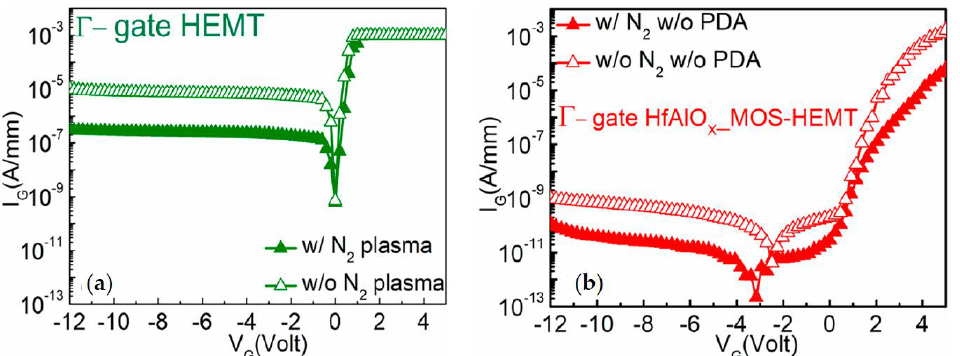
Figure 3. Comparison of gate leakage characteristics of ( a ) Γ -gate HEMT and ( b ) Γ -gate HfAlO X MOS-HEMT with and without the N 2 surface plasma treatment.